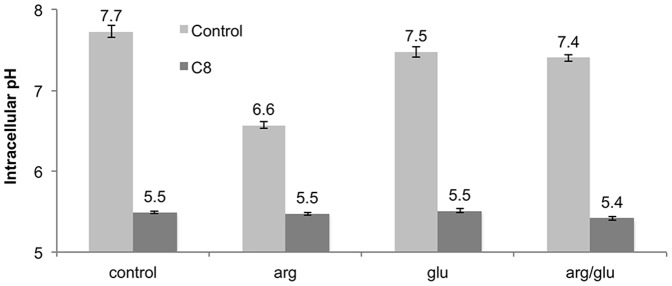
Supplementation with arginine or glutamate does not mitigate intracellular acidification.Measurements of the intracellular pH of E. coli MG1655 pJTD1 during C8 challenge while grown in the presence of supplemental arginine and glutamate. The cells were incubated for 3°C in MOPS media to allow utilization of the amino acid-dependent acid resistance systems. All concentrations are 10 mM.